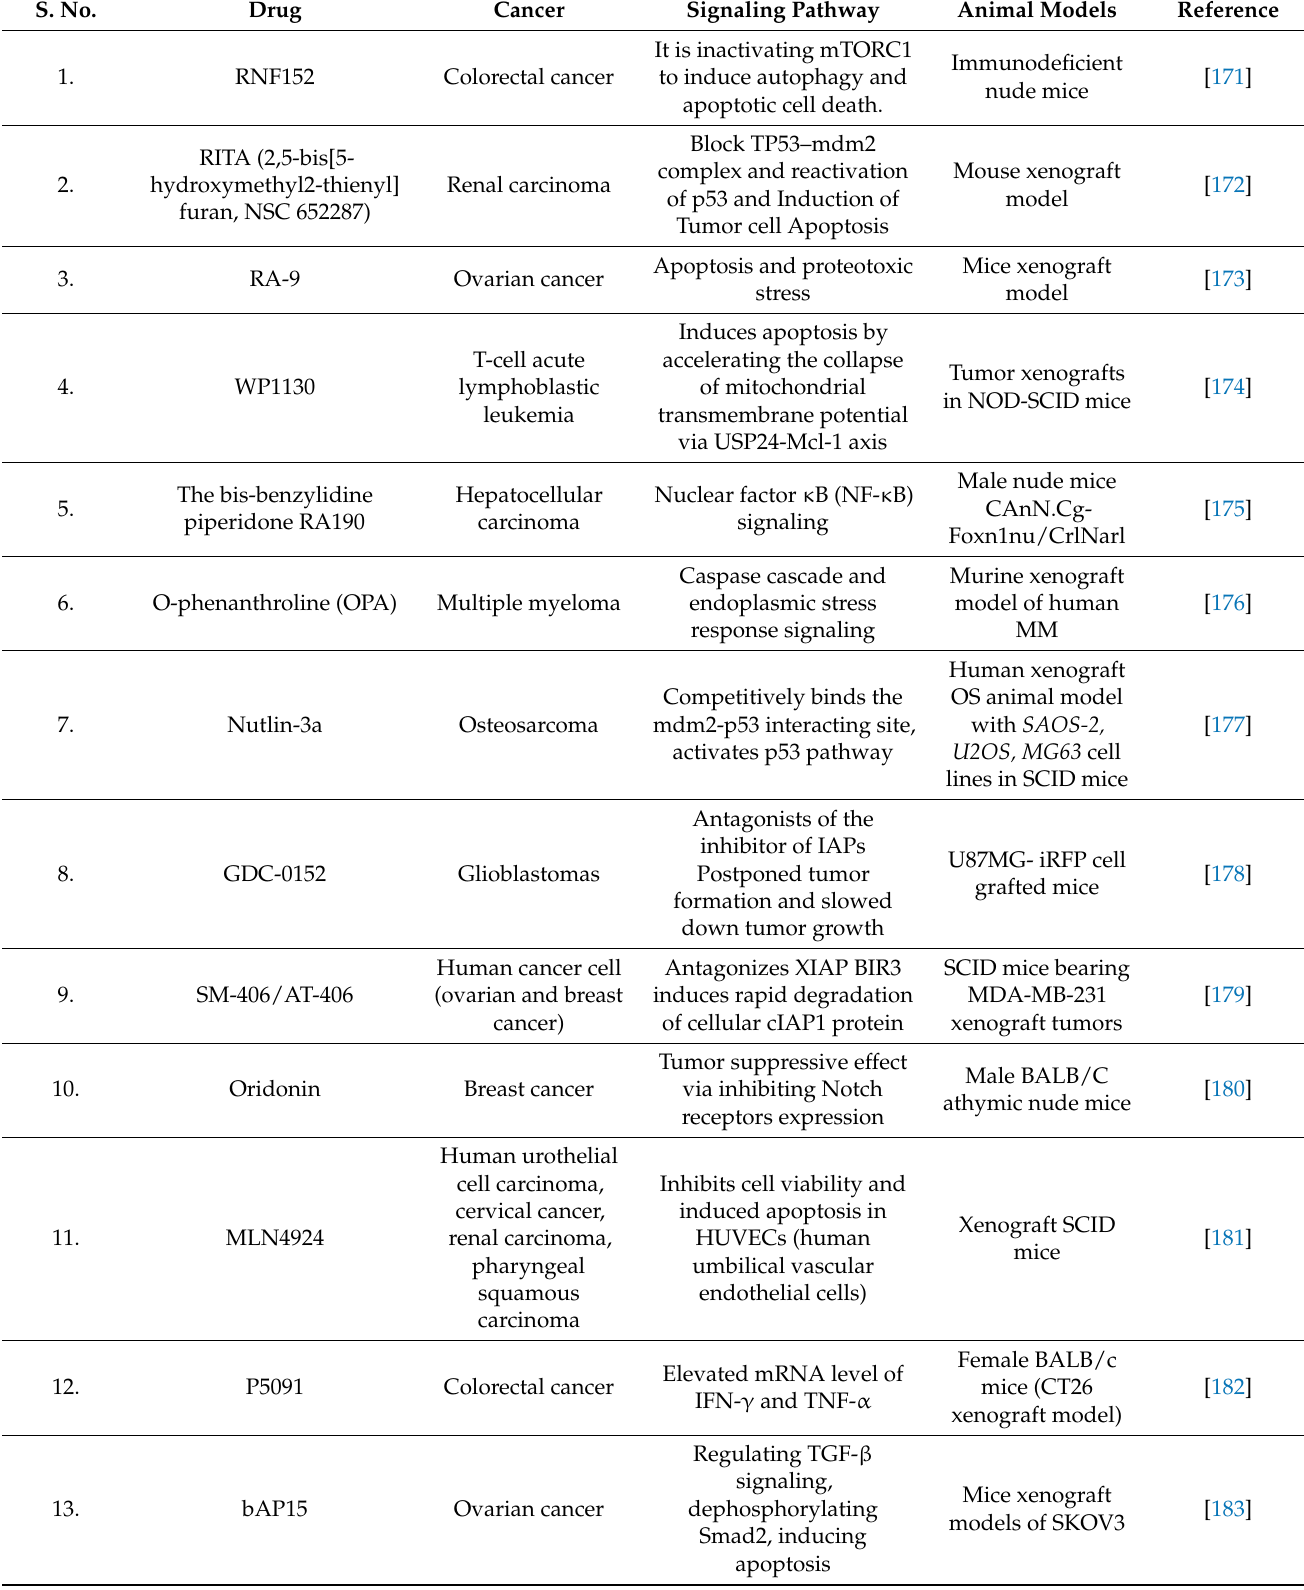
Table 2. In vivo studies of the ubiquitin inhibitors supporting the suppression of tumors. S.